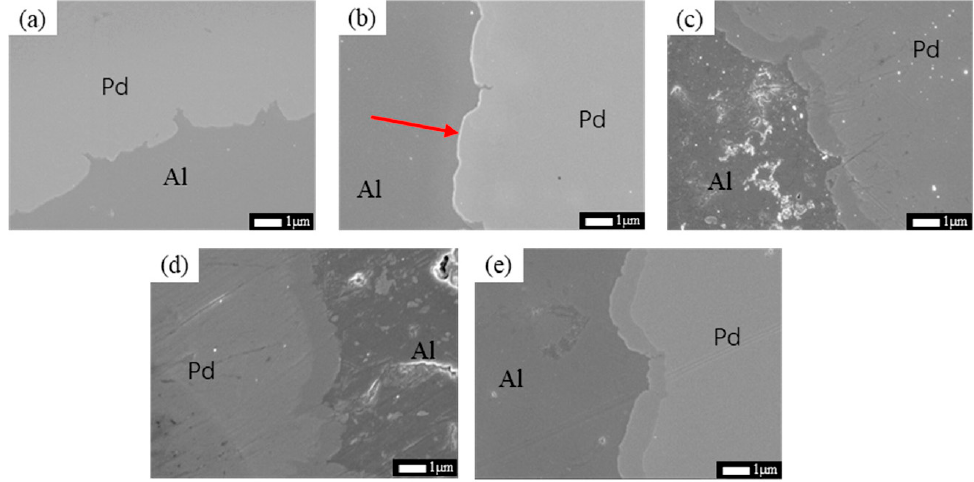
Figure 4. SEM images of Pd/Al composite wires annealed at 250 °C for different times; ( a ) 5 s, ( b ) 30 s, ( c ) 1800 s, ( d ) 3600 s, and ( e ) 10,800